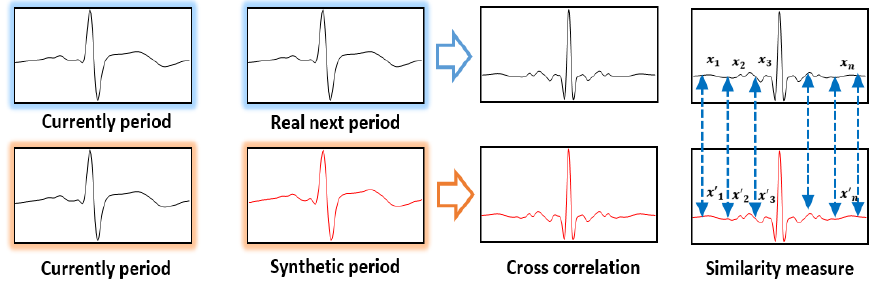
Figure 8. Similarity measurement method using euclidean distance on the basis of cross correlation. As the Euclidean distance of two cross correlations approaches 0, it indicates the gen- eration of synthetic ECG signals similar to the real ECG signals of the same experimentee; as it moves away from 0, it indicates a cross-correlation result of real ECG signals and synthetic signals between different